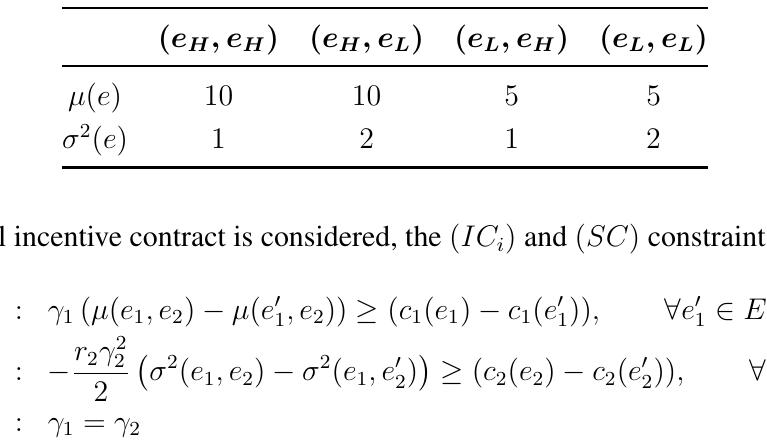
Table 1. The mean and variance figures of Example 1.